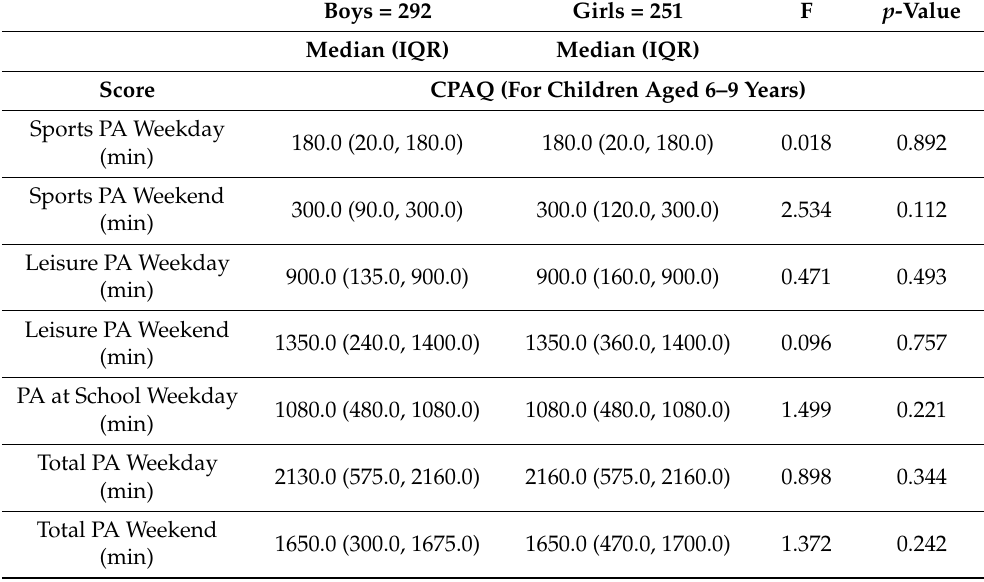
Table 2. Comparison of participants’ physical activity and sedentary behaviour scores across